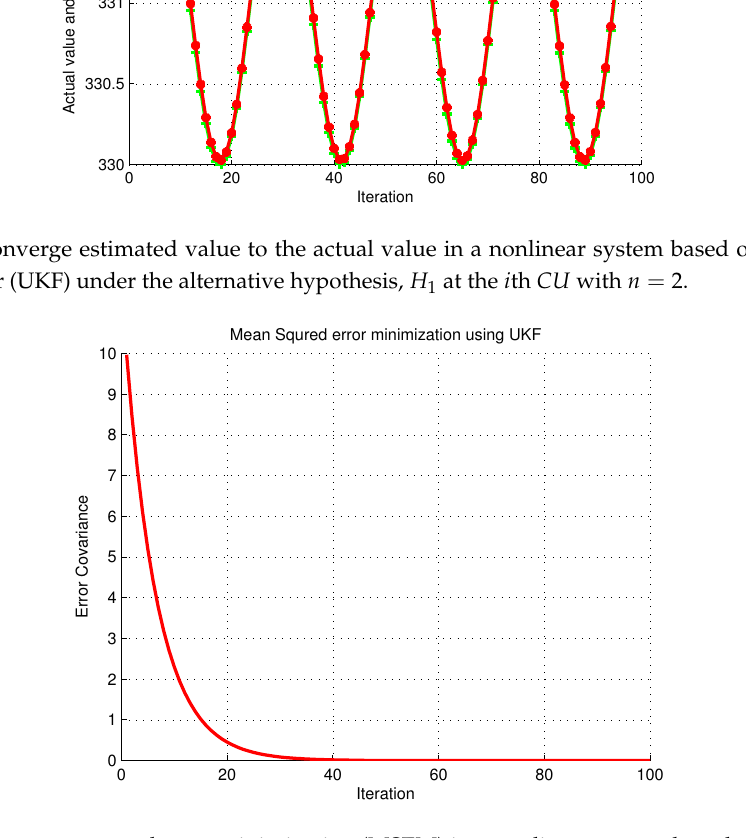
Figure 6. The mean squared error minimization (MSEM) in a nonlinear system based on unscented Kalman filter (UKF) under the alternative hypothesis, H 1 at the 1st CU 1 with n =